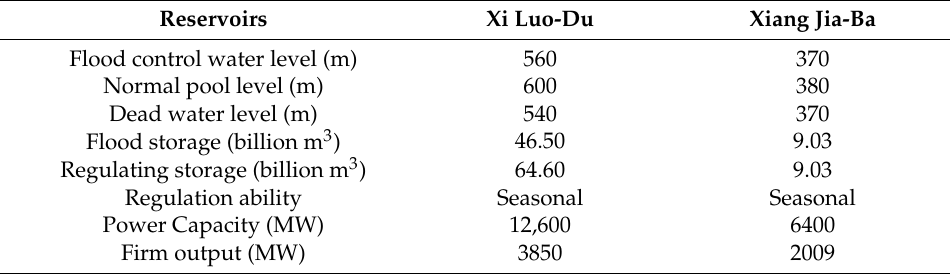
Table 1. Characteristics of the Xi Luo-du and Xiang Jia-ba reservoirs.